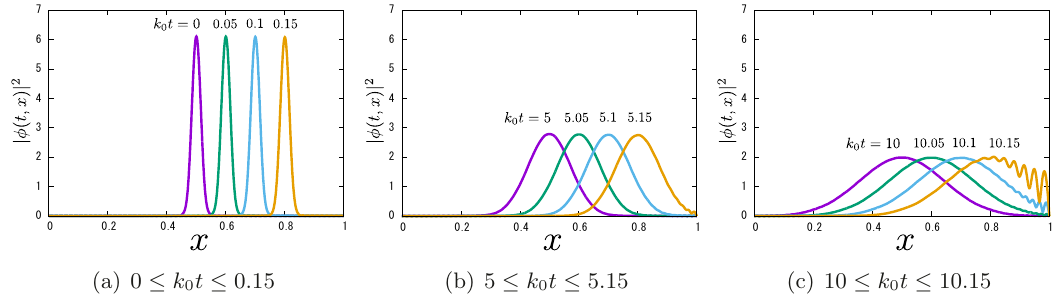
Figure 10 . Time evolution of a wave packet in a box ( k 0 = 3000 π and σ = 1 / (30 π )). around at the (2 N + 1)-th bounce. Here, ℓ ( t ) = 2 k 0 t + x 0 between the center of the wavepacket and the right boundary x = 1. Before the Ehrenfest time σ t 1, the 2-point OTOC is approximated by a step function. Therefore, for a ≪